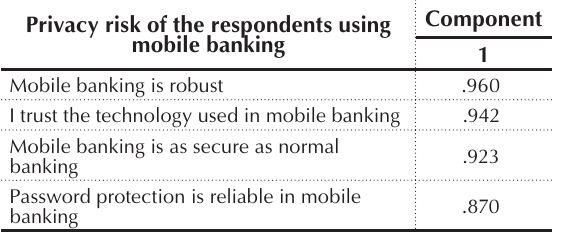
Table 7 represents factors affecting privacy risk.